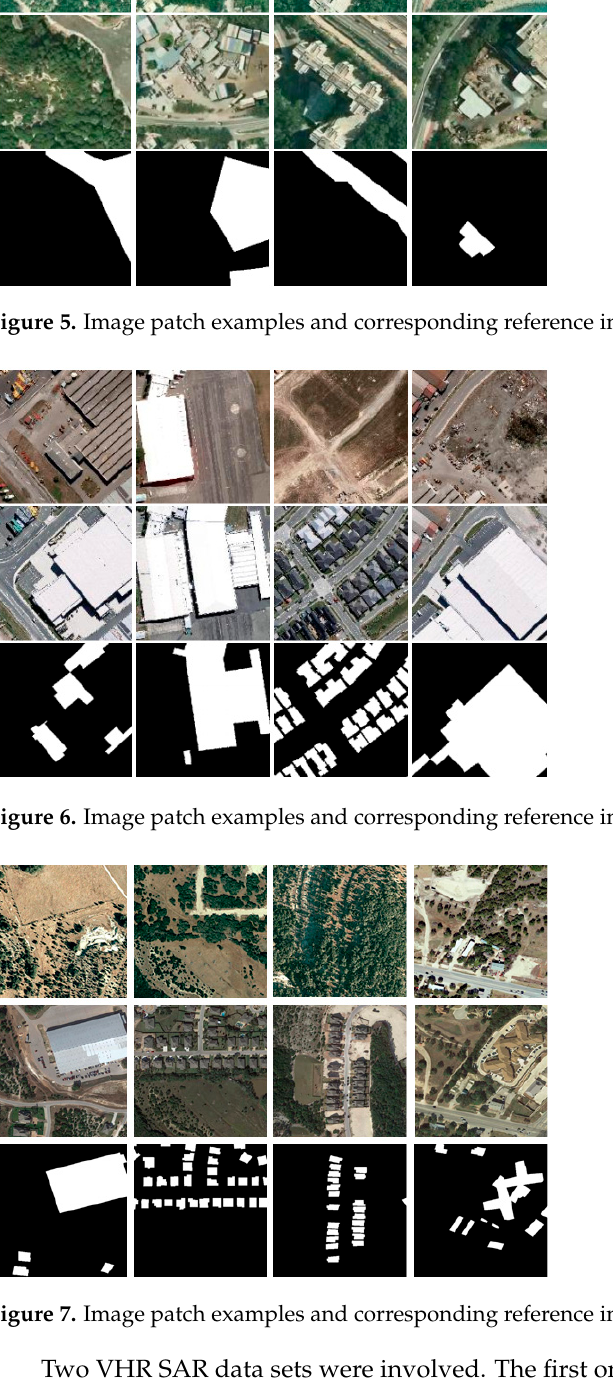
( c ) Figure 8. SAR data sets. ( a ) Image T1. ( b ) Image T2. ( c ) Reference change map. Five VHR heterogeneous optical/SAR data sets (Data 1~5) were involved. The first one consisted of an optical image acquired by QuickBird in July 2006 and an SAR image captured by TerraSAR-X in July 2007, with a spatial resolution of 0.65 m. The mainly changed information was the flooding in Gloucester, England. The second to the fifth data sets all included a Google image and a Gaofen-3 SAR image, covering different cit- ies in China, including Shanghai, Zhengzhou, Huizhou and Xiangshui, respectively. The spatial resolution was 1 m and the main types of changes were construction and demoli- tion of buildings, and areas covered by water. These five data sets are shown in Figure 9.